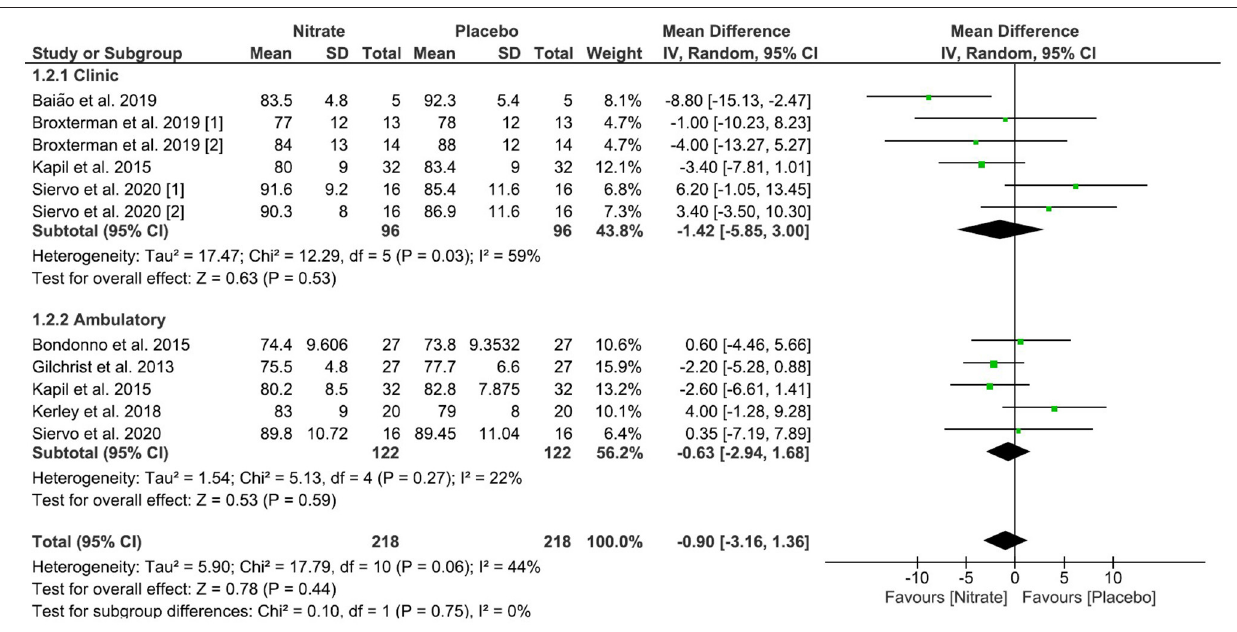
FIGURE 4 | Effects of NO 3 derived from BRJ on DBP (mmHg)